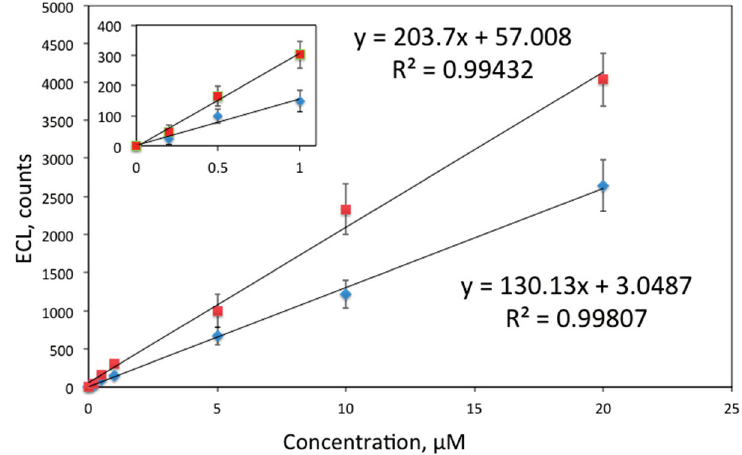
Figure 7. Calibration curves for putrescine (quadrates) and cadaverine (diamonds), measured in 0.05 M tetraborate buffer, pH 9.2. Conditions: ECL signal was generated by sweeping potential from 0.8 to 1.3 V vs. an Ag/AgCl reference electrode and recorded with PMT via an optical fibre. The inset shows the calibration plot at low concentrations ( ≤ 1 μ